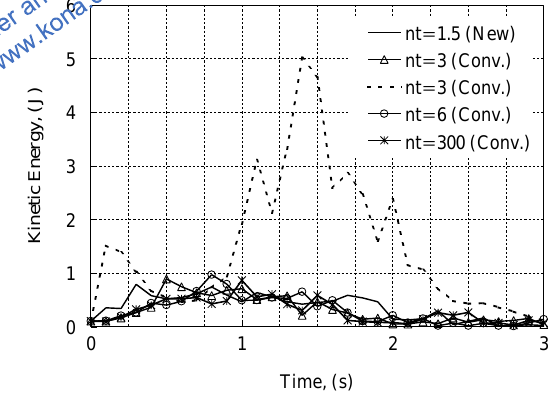
Kinetic energy of total particles in discharge simulation